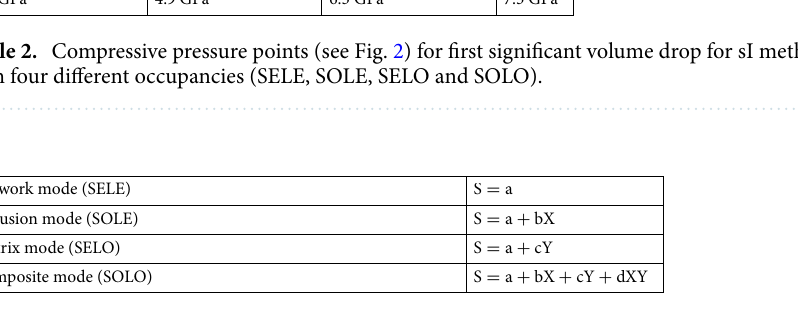
Table 3. The four occupancy modes that contribute to the overall compressive stability model in Eq. (1).